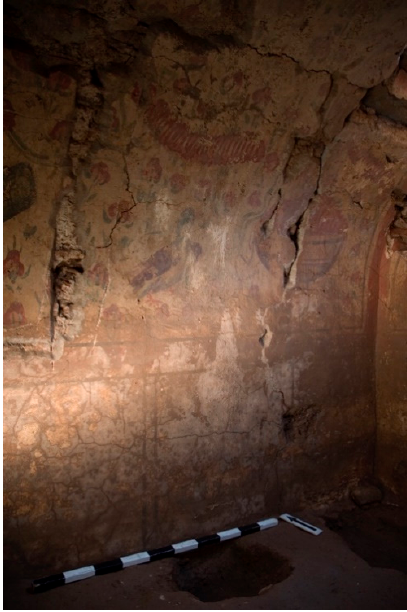
Figure 17. Sardis, Tomb 07.3 (Appendix A.5), north wall. © Archaeological Exploration of Sardis/President and fellows of Harvard College.